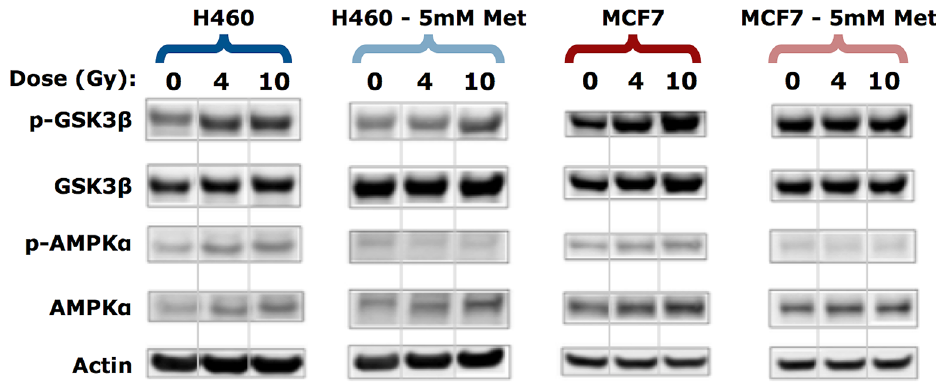
Fig 4. Metformin suppresses GSK-3 β but not AMPK α . Western blotting was performed on lysates collected 3 days post-irradiation using the indicated antibodies, n = 3 experiments. Actin was used as a loading control. Each panel was generated as a composite from the same gel with non-adjacent bands separated by a vertical line.